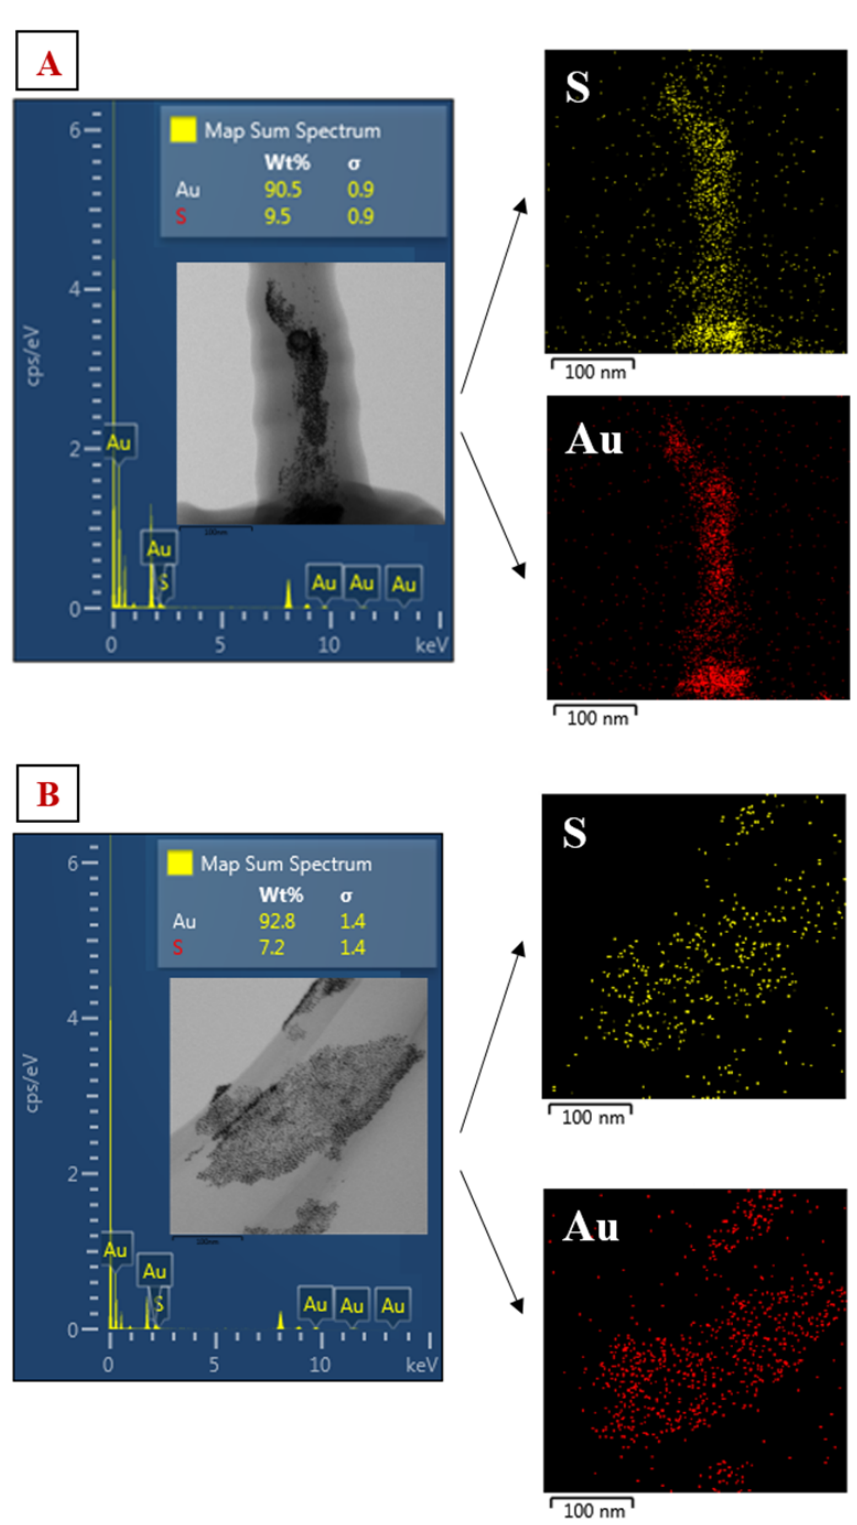
Figure 9. ( A ) Sample analysis of AuNP-900 s/NALC/H 2 O at an NALC/H 2 O ratio of 0.5 g/100 mL; EDS spectrum—Au and S in the sample. HRTEM image of the sample, EDS mapping of Au and S content in solution. ( B ) Analysis of AuNP-600 s/NALC/H 2 O sample at an NALC/H 2 O ratio of 0.5 g/100 mL; EDS spectrum—Au and S in the sample. HRTEM image of the sample, EDS mapping of Au and S content in solution.